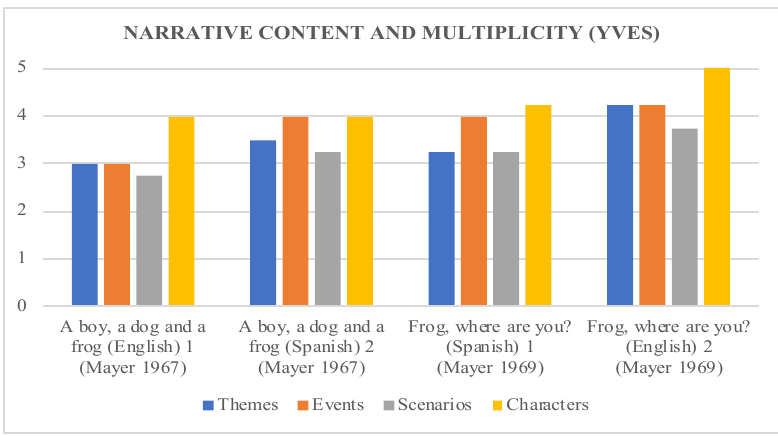
Figure 9 . Yves’ scores for the narrative content and multiplicity dimension.